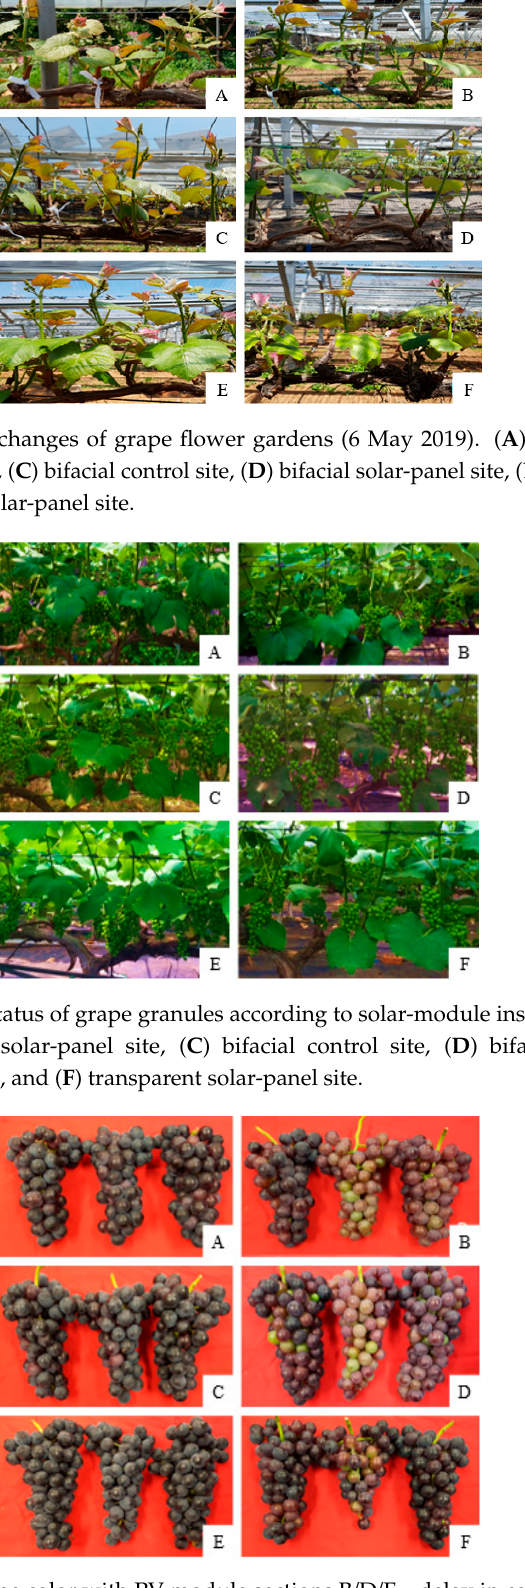
Figure 23. Changes in grape color with PV module sections B/D/F—delay in coloration. ( A ) Normal control site, ( B ) normal solar-panel site, ( C ) bifacial control site, ( D ) bifacial solar-panel site, ( E ) transparent control site, and ( F ) transparent solar-panel site.